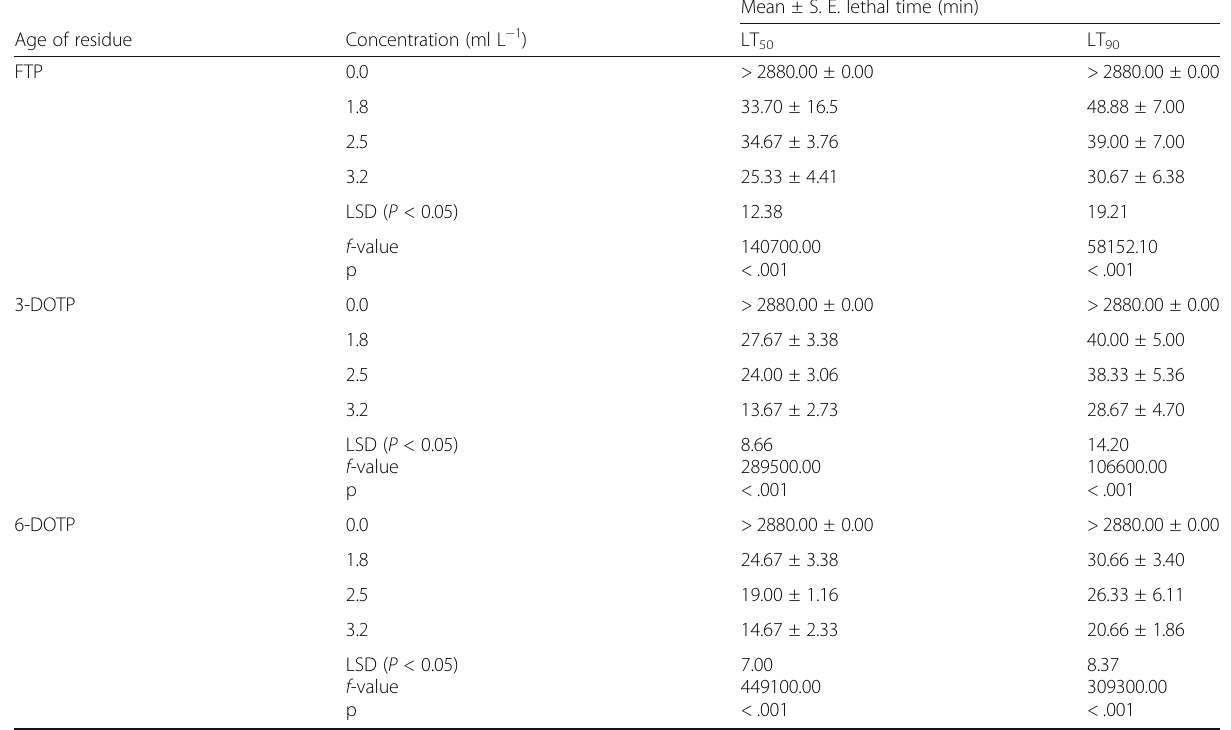
Legend: FTP freshly treated panels, 3-DOTP 3-day-old-treated panels, 6-DOTP 6-day-old-treated panels